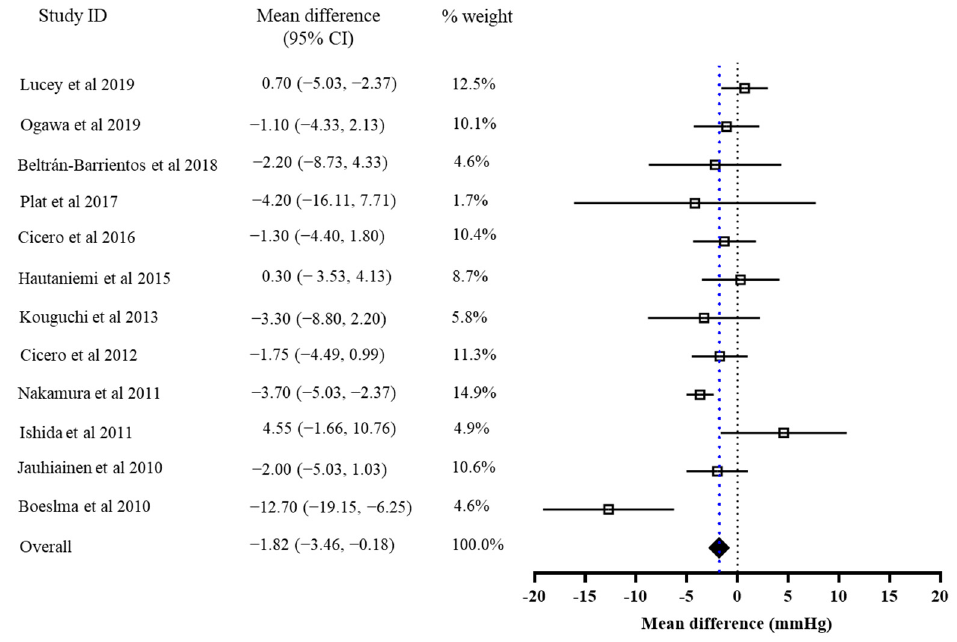
Figure 3. Overall change in DBP (mmHg) after the peptide intervention.